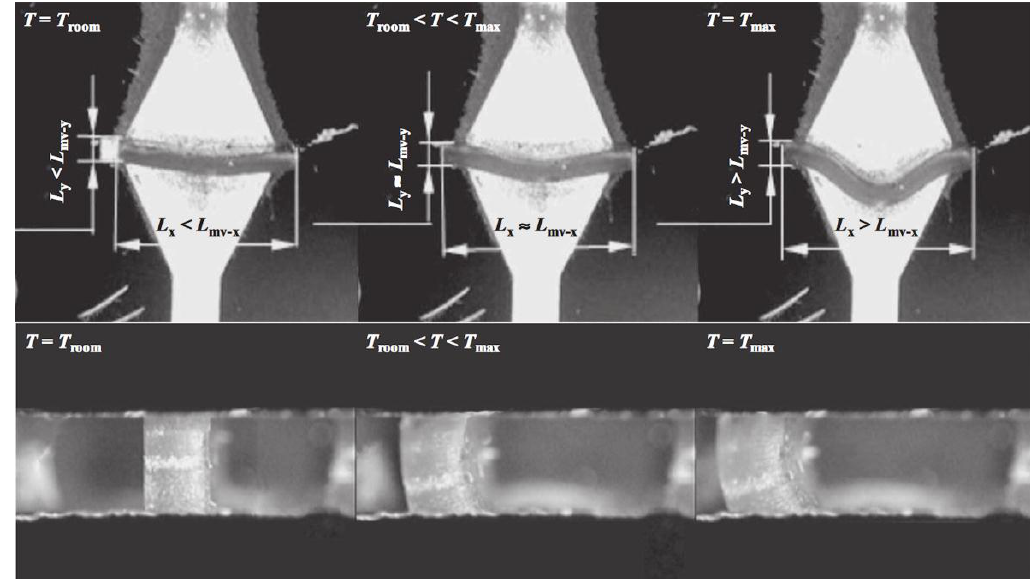
Figure 4. Snapshots pictures taken during the actuation of the LCE microvalve developed by Sanchez- Ferrer et al. The working temperature is T N/I = 80.5 °C. Reprinted with permission from Reference [57].